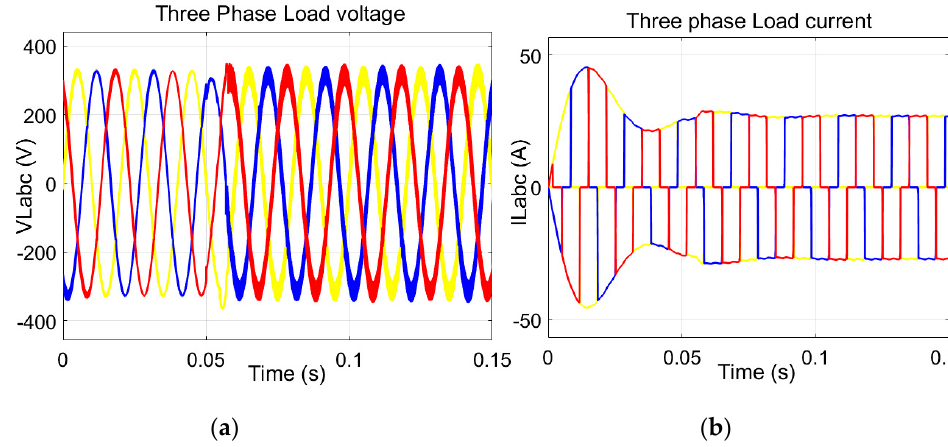
Figure 13. ( a ) Load voltage. ( b ) Load current.